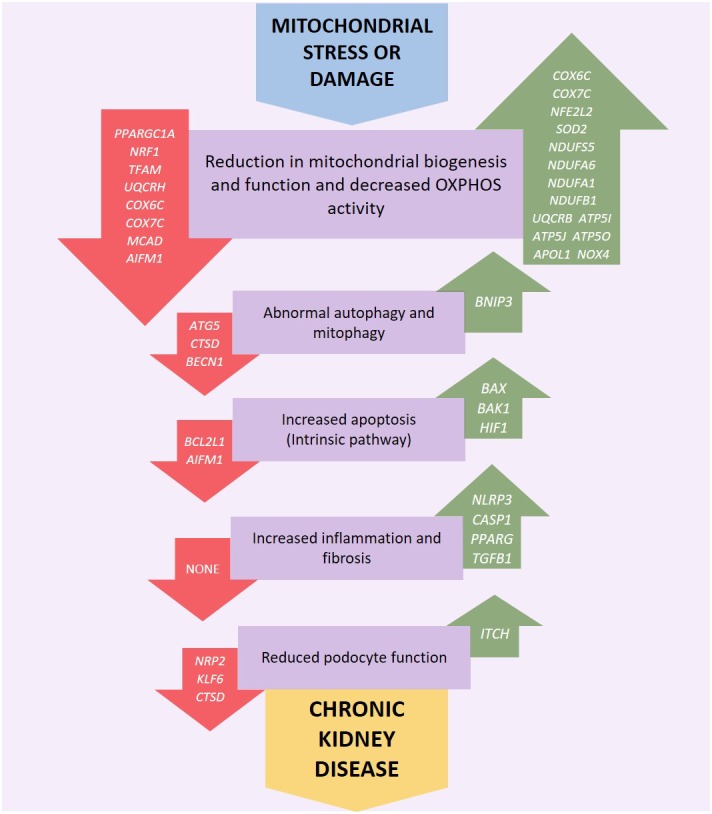
Genetic variation or altered expression of nuclear genes which encode mitochondrial proteins may impair respiratory chain complex activities leading to an increase in production of reactive oxygen species (ROS). This initiates a negative feedback loop, further reducing mitochondrial function, and ATP production along with an increase in OXPHOS defects and ROS generation leading to increased oxidative stress which may lead to uncontrolled autophagy, mitophagy and further ROS production. Mitochondrial dysfunction, ROS generation and the resulting dysregulation of autophagic mechanisms may also activate intrinsic apoptotic mechanisms resulting in inflammation and fibrosis in the renal tubules, glomerulus and podocytes eventually leading to kidney disease. Red arrows indicate underexpression and green arrows overexpression.